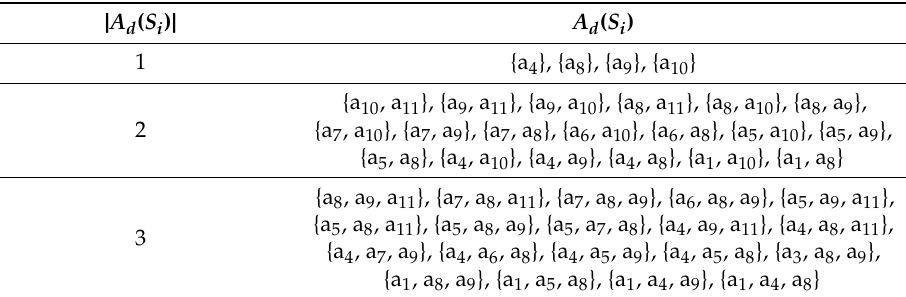
Table 11. I = 1 for all arc sets with recovery cost limit c = 10.